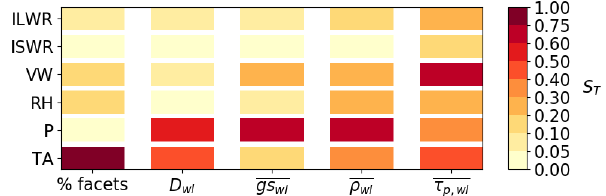
Figure 3. Total sensitivity index of weak layer variables on meteo- rological input uncertainty on 2 January 2017. Weak layer variables are the proportion of faceted layers (% facets), weak layer thick- ness ( D wl ), weak layer grain size (gs wl ), weak layer density ( ρ wl ) and weak layer shear strength ( τ p , wl